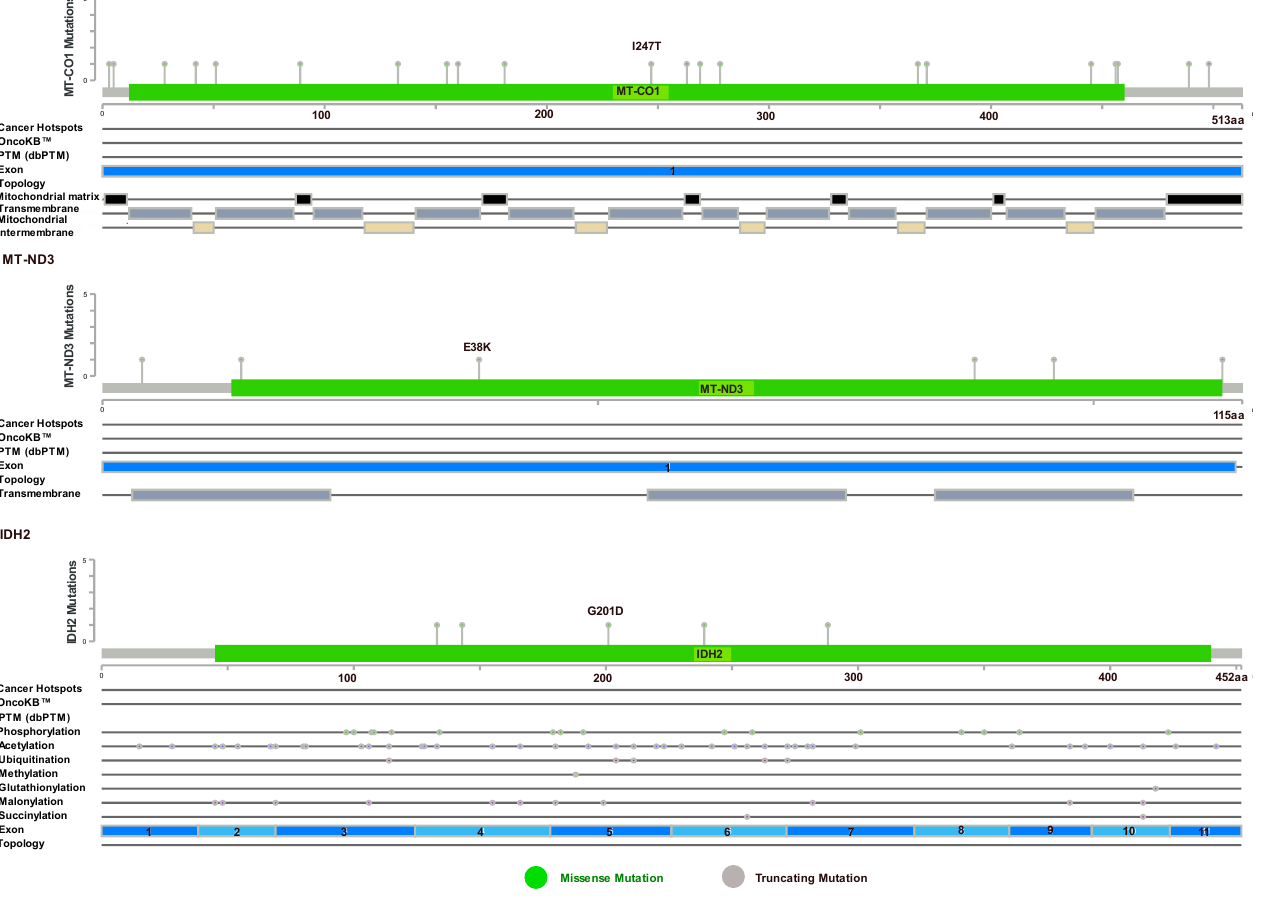
Figure 3. Lollipop diagram of mtDNA MT-CO1, MT-ND3, and IDH2 in PDAC. (Data source: https://www.cbioportal.org/ [105].) Table 1. Role of mitochondrial DNA in PDAC progression. (Data source: https://www.cbiopor- tal.org/ [105].)